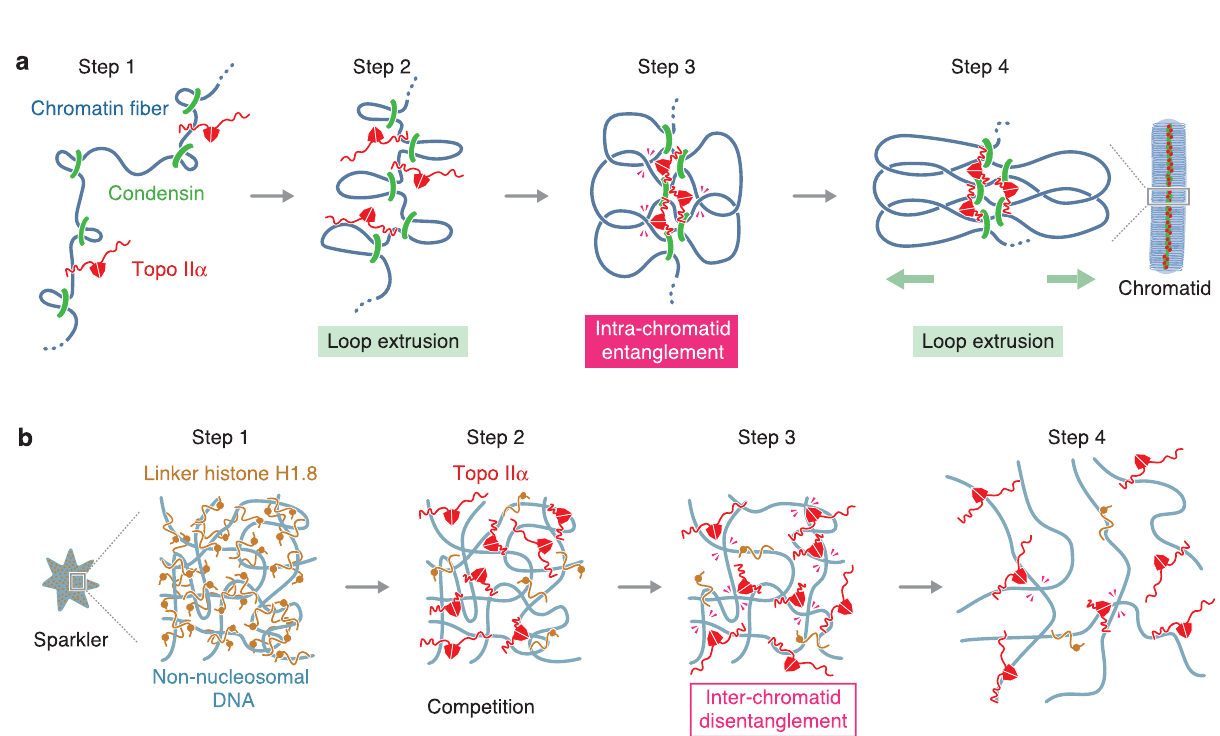
Fig. 6 Models for the actions of topo II α in crowded environments created during mitotic chromatid assembly. a A model for chromatid thickening by collaborative actions of topo II α and condensins. At the initial step of chromatid assembly, intra-chromatid entanglements are hardly generated because loops are distantly located from one another (step 1). As condensins extrude the loops, the distance between neighboring loops gets shortened (step 2), allowing chromatin-associated topo II α to generate entanglements between loops (step 3: intra-chromatid entanglement). The resultant intra-chromatid entanglements in turn stabilize chromatid axes and may promote further extrusion of the loops and thickening of the chromatids (step 4). For simplicity, structural changes of an individualized, single chromatid are shown here. b A model for resolution of a pre-assembled sparkler. A sparkler is composed of multiple non-nucleosomal DNAs that are heavily entangled with each other and bound by the linker histone H1.8 (step 1). When topo II α is added into the reaction, its CTD competes with the linker histone for the non-nucleosomal DNAs and delivers the enzymatic core into the inside of the sparkler (step 2). Topo II α catalyzes disentanglement reactions there (step 3: inter-chromatid disentanglement), which in turn promotes further dissociation of the linker histone and resolves the sparkler (step 4). For simplicity, condensins ’ actions are not depicted